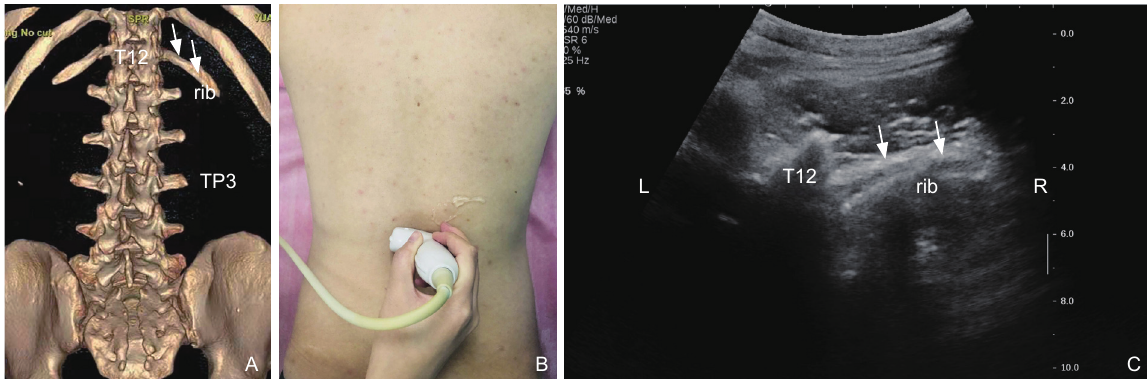
Figure 3 Transversal section of T12. (A) The white arrows indicate the 12 th rib. (B) The position of the probe on human skin. (C) Ultrasound image of the connection of T12 to the 12 th rib. The white arrows indicate the 12 th rib. T12, the 12 th thoracic vertebra; TP3, the transverse process of L3.